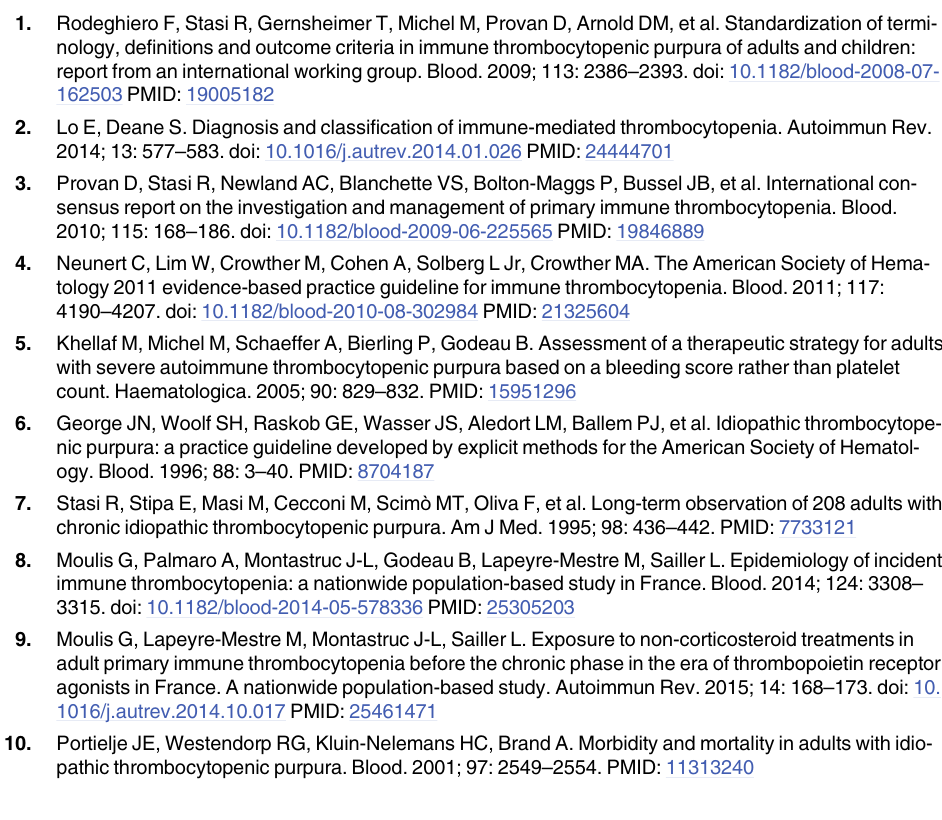
Table D. Full multivariate model assessing the link between exposure to corticosteroids during the month before index date and occurrence of severe infection. This model had the lowest Akaike criterion value (331.921). Table E. Full multivariate model assessing the link between exposure to corticosteroids during the month before index date and occurrence of severe infection, without withdrawal from the model of the exposure to rituximab in the month before index date. Table F. Full multivariate model assessing the link between exposure to corticosteroids during the month before index date and occurrence of severe infection: sensitivity analysis adding the variable corresponding to the occurrence of a hospitalization of at least 7 days between start of follow-up and index